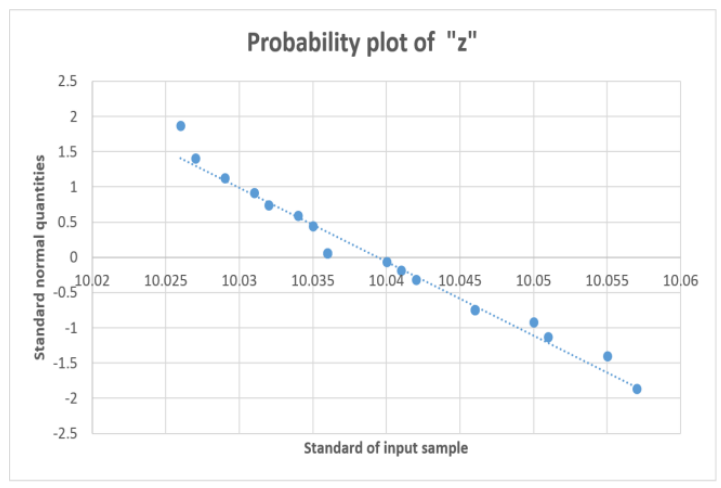
Appl. Sci. 2022 , 12 , x FOR PEER REVIEW Figure 10. Normality test for “ y ” axis of sensing object. Figure 10. Normality test for “ y ” axis of sensing object.